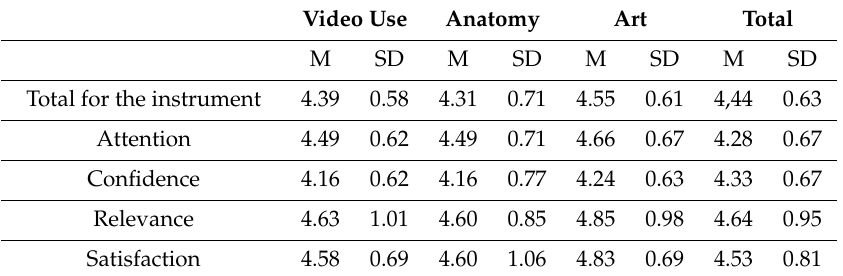
Table 3. Means and standard deviations for the IMMS instrument and for its dimensions. Video